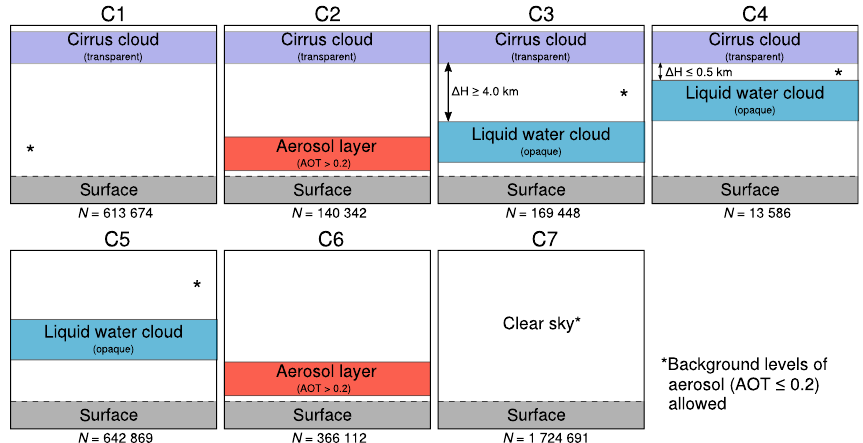
Figure 5. Visualisation of the seven vertical cloud–aerosol structure classes. Classes C1–C4 contain transparent cirrus clouds and are used to characterise the CiPS cirrus cloud detection (probability of detection) together with the CTH CiPS , IOT CiPS and IWP CiPS retrievals. Classes C5–C7 contain no cirrus clouds and are used to characterise the false alarm rate of the CiPS cirrus cloud detection.